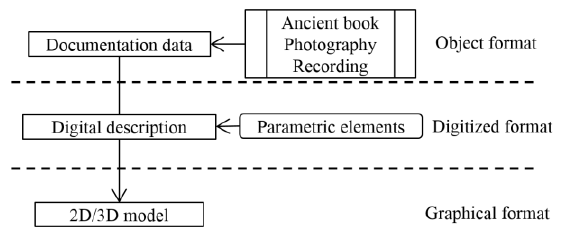
Fig. 2: The processing of documentation-based Historic modelling